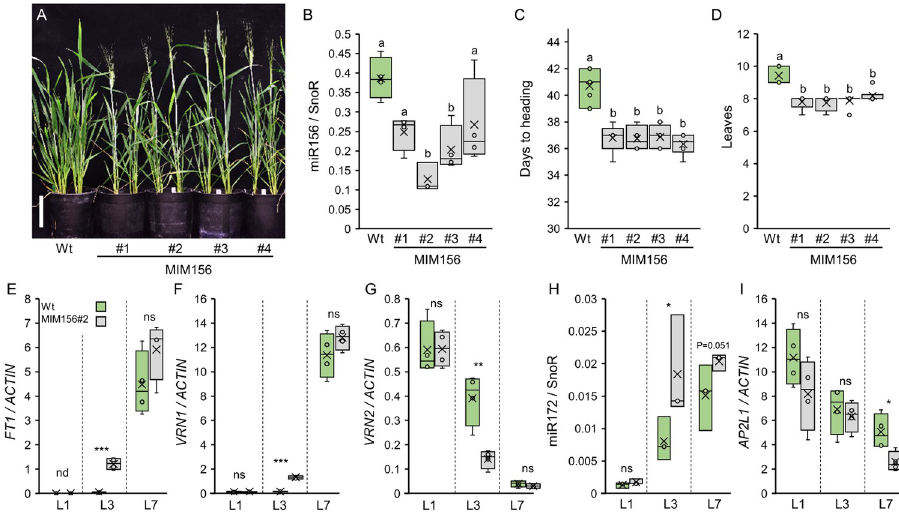
Fig 4. Transgenic target mimic MIM156 induces expression of flowering promoting genes and accelerates heading time. (A ) Five-week-old wild type Kronos (Wt) and T 1 plants of four independent MIM156 transgenic lines grown under LD. Scale bar = 10 cm. ( B ) Box plots showing the expression levels of miR156 determined by qRT-PCR in the 1 st leaves (L1) of wild type Kronos plants (Wt) and T 1 plants of four independent MIM156 lines grown under LD. SnoR was used as internal reference. Data correspond to four independent biological replicates. ( C-D ) Box plots showing days to heading ( C ; n � 4) and the number of leaves produced by the main tiller ( D ; n � 4) for wild type Kronos (Wt) and four independent MIM156 T 1 lines grown under LD. ( E-I ) Box plots showing the expression levels of FT1 ( E ), VRN1 ( F ), VRN2 ( G ), miR172 ( H ) and AP2L1 ( I ) determined by qRT-PCR in the 1 st (L1), 3 rd (L3) and 7 th (L7) leaves of wild type Kronos (Wt) and MIM156#2 growing under LD. As internal references, we used ACTIN for FT1 , VRN1 , VRN2 and AP2L1 , and SnoR for miR172. Data correspond to four independent biological replicates. Different letters above the box plots indicate significant differences based on Tukey tests in panels B and D